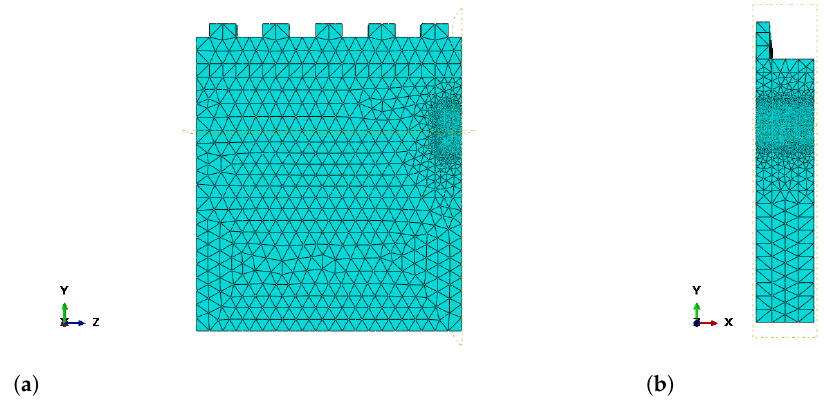
Figure 3. Finite element model mesh: ( a ) front view and ( b ) side